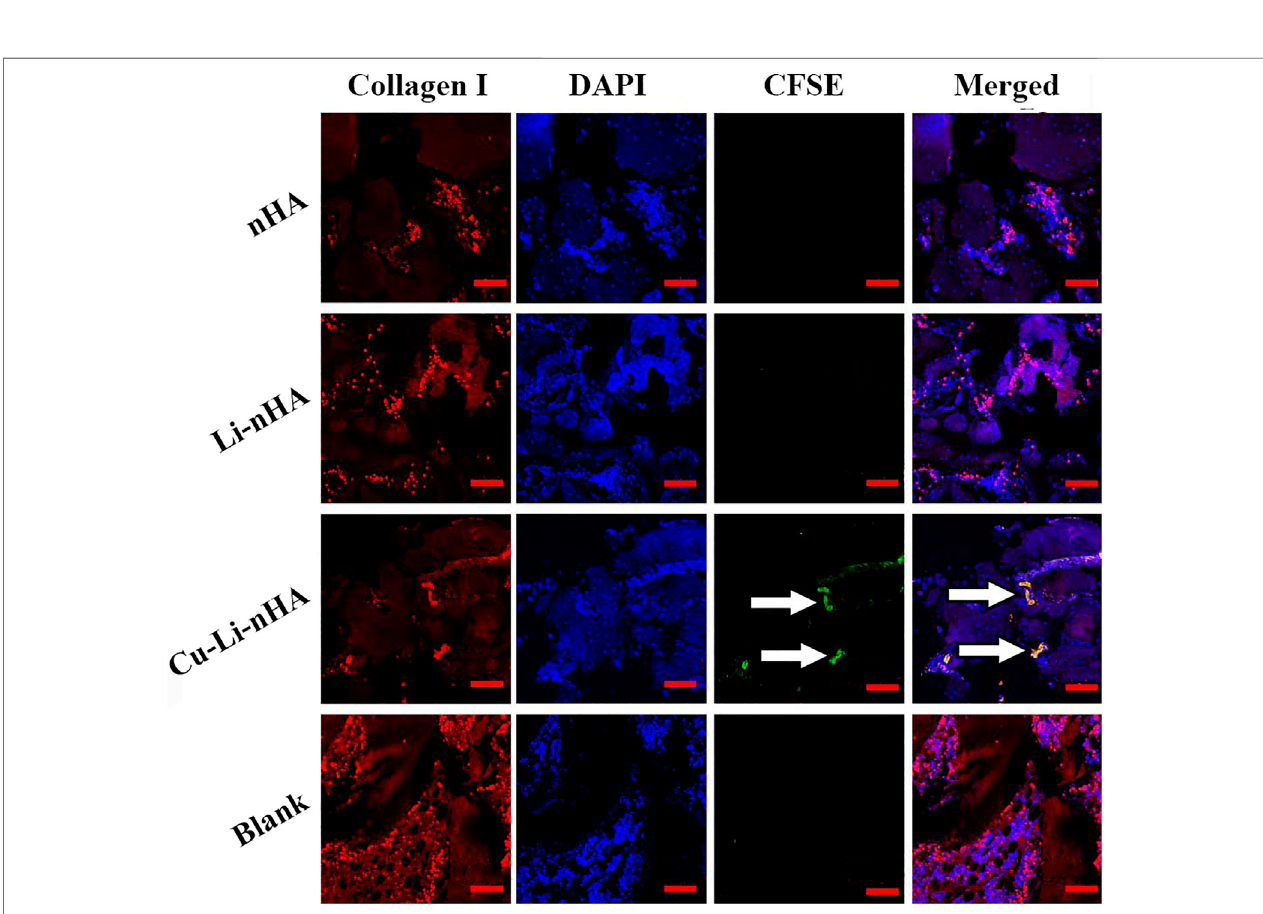
FIGURE6 | Immuno fl uorescence assaystoverify BMSCs homing 2 weeks after injecting withexogenousCFSE-labeled BMSCs. BMSCsin the implanted regions were shown under the Collagen I signal (red), and homing BMSCs were shown under the CFSE signal (green). White arrow: CFSE-labeled BMSCs. Scale bar in the bottom right-hand corner of each image (red): 200 μ